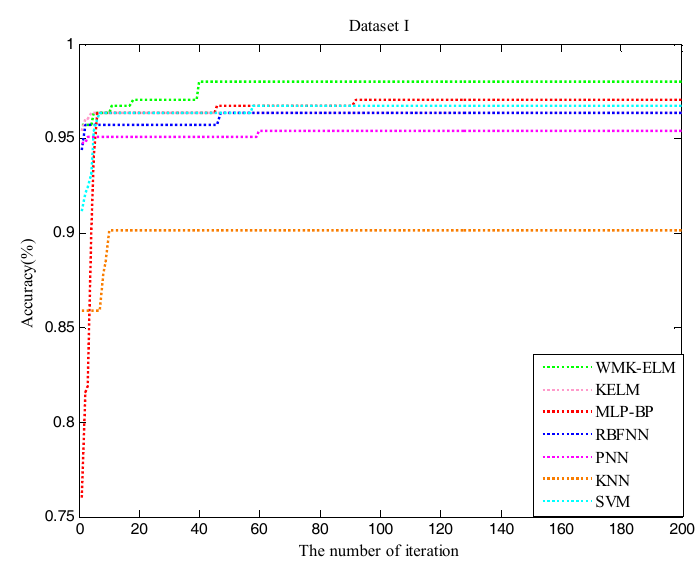
Figure 5. The accuracy of QWMK-ELM and the control classifiers in the process of optimization for Dataset I.